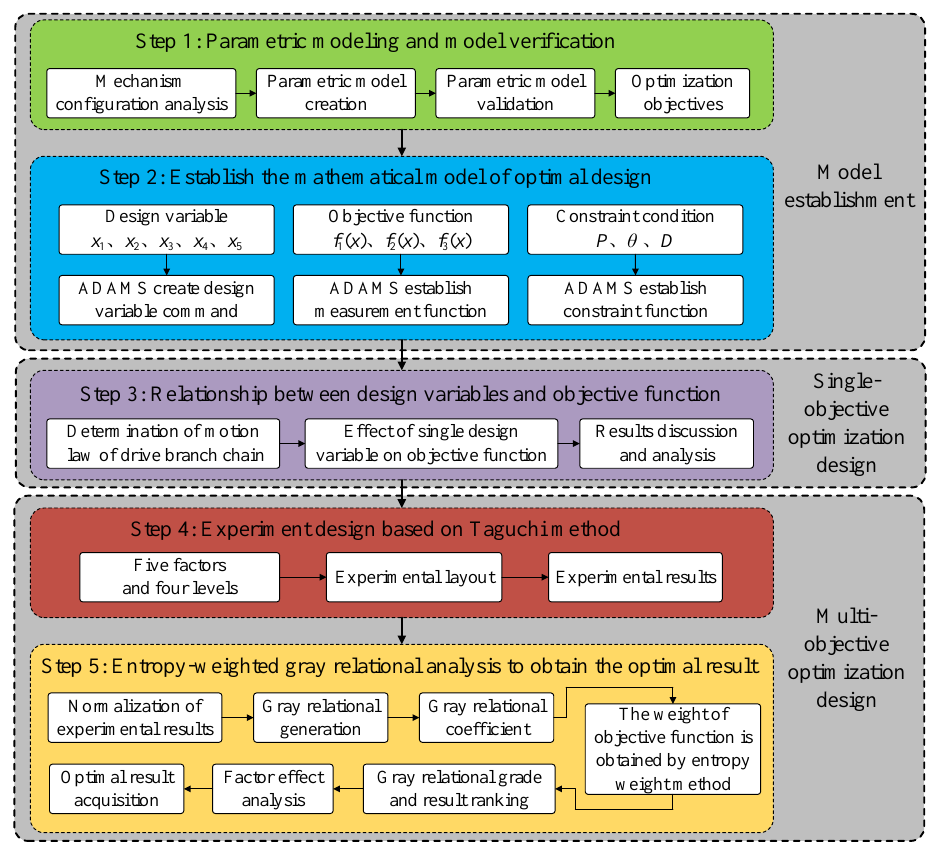
Figure 1. Optimization design